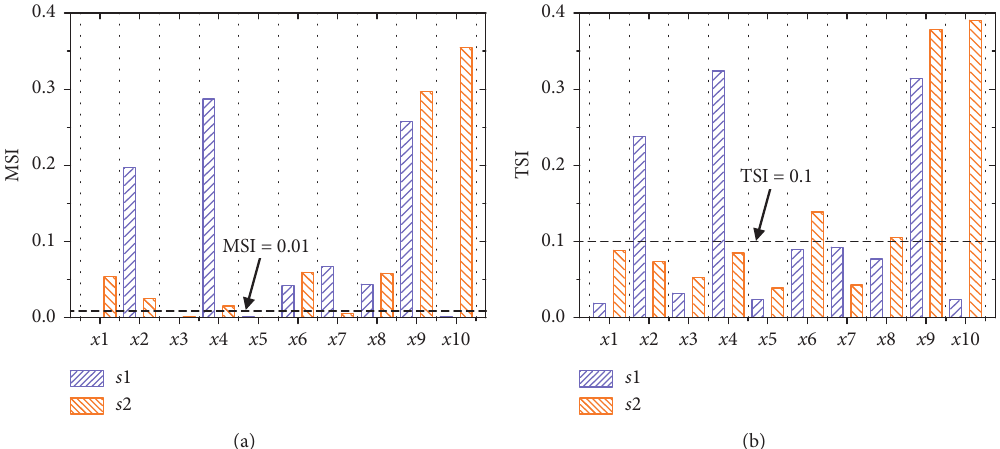
Figure 6: The full results of MSIs and TSIs for all 10 input parameters on the two output parameters, under the sample size of 22528: (a) MSI; (b) TSI.